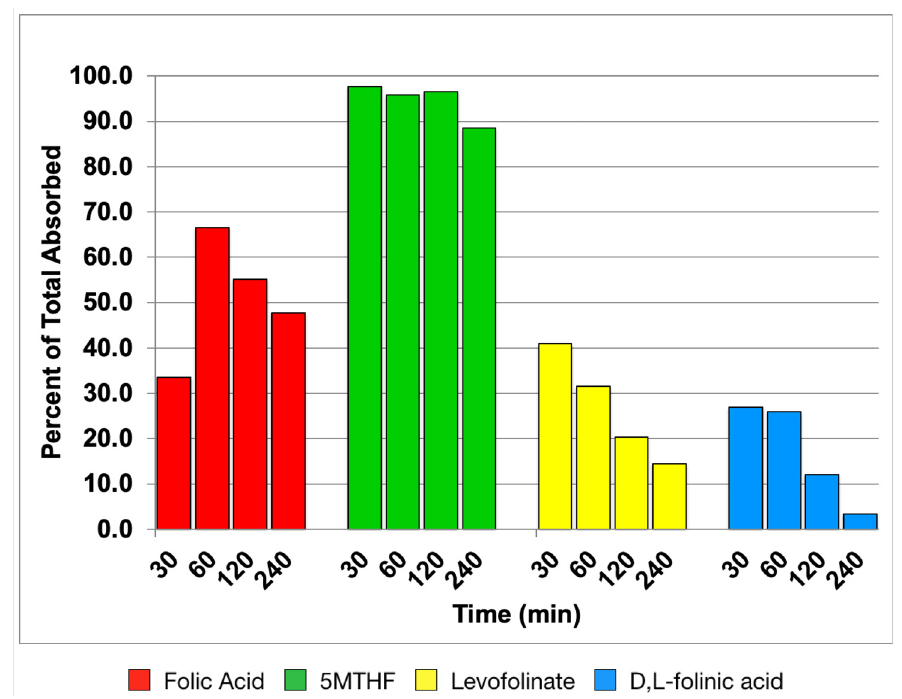
Figure 2. Absorbed unconverted folate form in blood. The values are expressed as a percentage of total folate in the serum. Levofolinate and d,l-folinic acid identified as unconverted are deduced from the total concentration in the serum. Therefore, the MTHF formed is likely to include THF and formyl-THF formed, which are minor components of the unconverted folate forms. MTHF administered appears to be absorbed as such without further conversion.